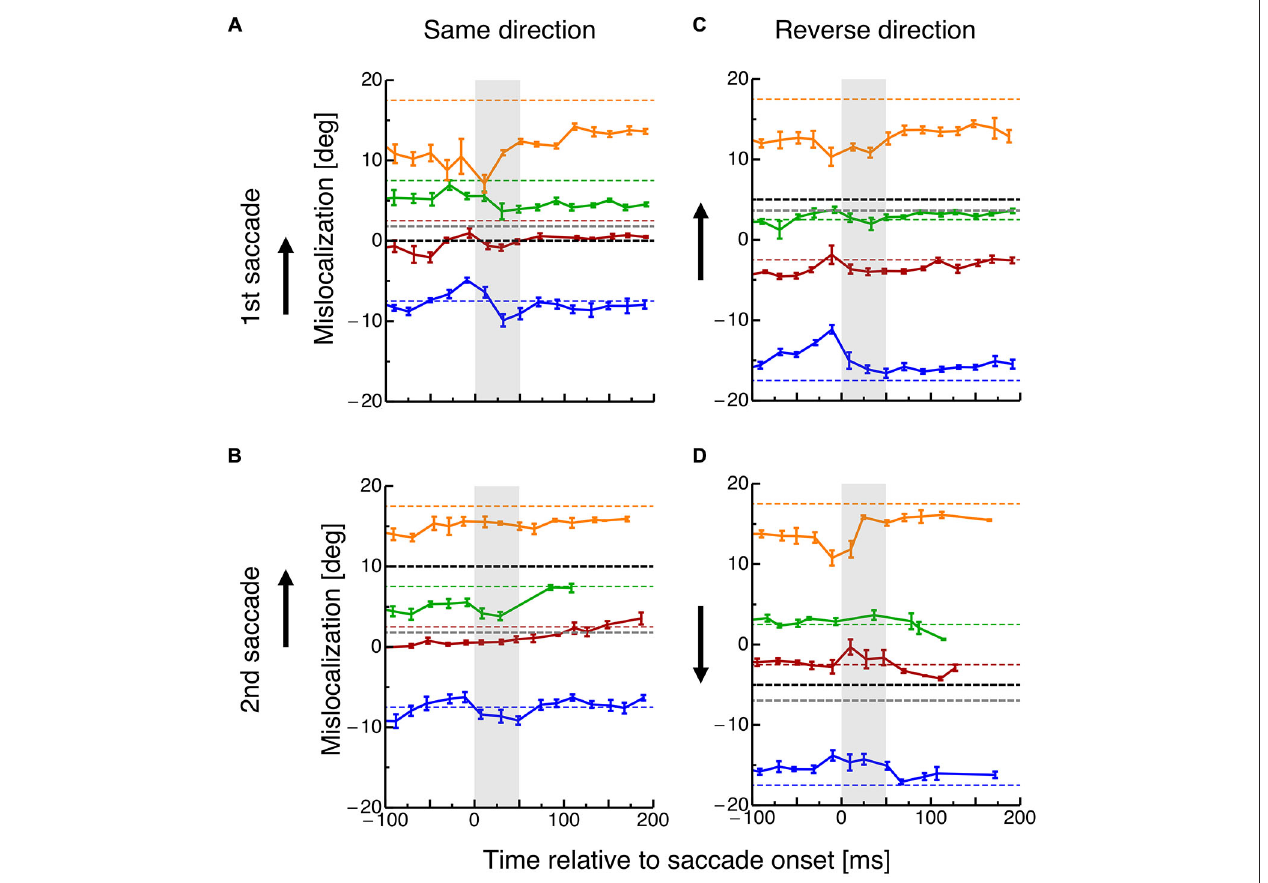
FIGURE 3 | (A) Localization of the probe dot relative to onset of the first saccade in the same-direction double-step task. Different colors refer to the eight different positions of the probe dot as shown in Figure 1B . Data are pooled across subjects and binned into bins with a width of 20 ms. Error bars represent S.E.M. (B) Localization of the probe dot relative to onset of the second saccade in the same-direction double-step task. Same conventions as in (A) . (C) Localization of the probe dot relative to onset of the first saccade in the reverse-direction double-step task. Same conventions as in (A) . (D) Localization of the probe dot relative to onset of the second saccade in the reverse-direction double-step task. Same conventions as in (A)